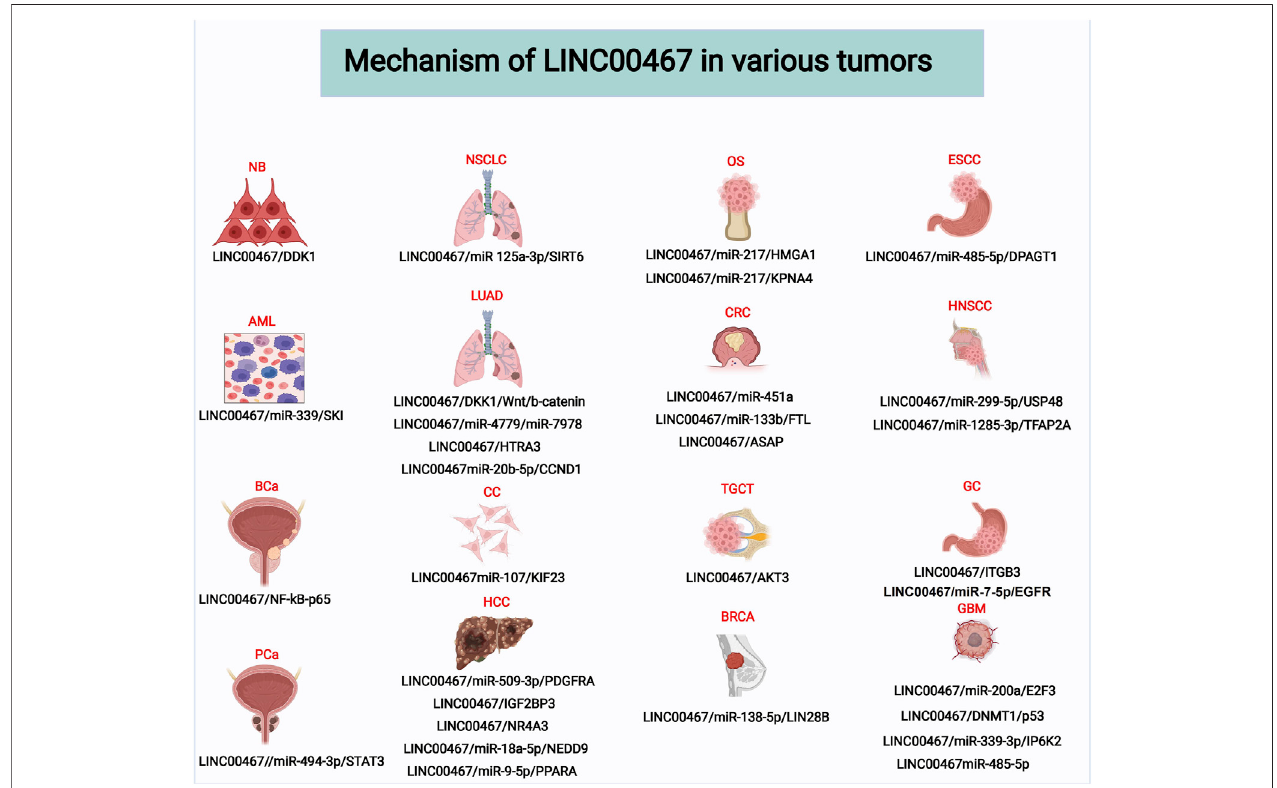
FIGURE2| Molecular mechanisms ofLINC00467invarious tumors.Abbreviations:NB,Neuroblastoma;NSCLC,Non-smallcelllungcancer;OS,Osteosarcoma; ESCC, Esophageal squamous cell carcinoma; AML, Acute Myeloid Leukemia; LUAD, Lung adenocarcinoma; CRC, Colorectal cancer; HNSCC, Head and neck squamous cell carcinoma; BCa, Bladder Cancer; CC, Cervical cancer; TGCT, Testicular germ cell tumor; GC, Gastric cancer; PCa, Prostate cancer; HCC, Hepatocellular carcinoma; BRCA, Breast Cancer; GBM,